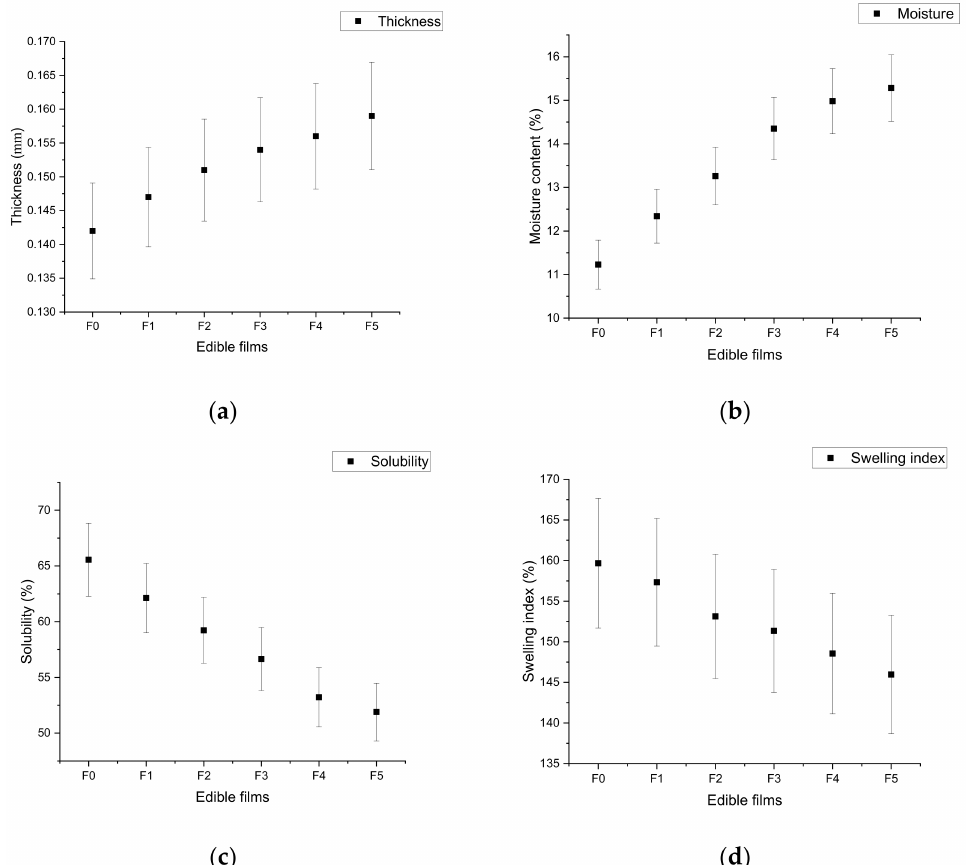
Figure 2. Effect of pomegranate peel extract on thickness ( a ), moisture content ( b ), solubility ( c ), and swelling index ( d ) of chitosan-based edible films. F0 = control (chitosan), F1 = 0.2 g/mL PGP, F2 = 0.4 g/mL PGP, F3 = 0.6 g/mL PGP, F4 = 0.8 g/mL PGP, and F5 = 0.10 g/mL